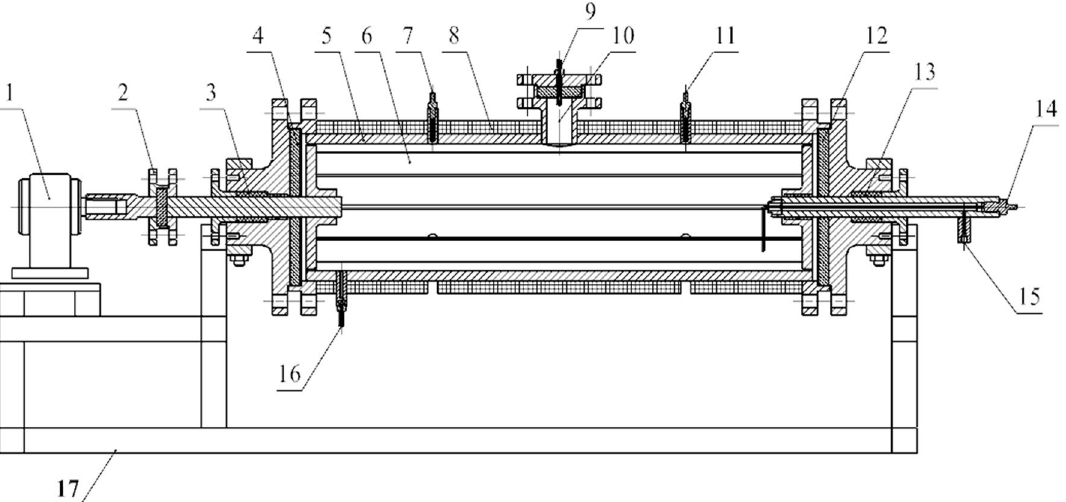
Fig. 2 Detailed structures of TDU (1 reducer; 2 heat insulation cou- pling; 3 packing seal; 4 heat shield; 5 barrel; 6 rotary scraper; 7 ther- mocouple; 8 electromagnetic induction heating and insulation layer; 9